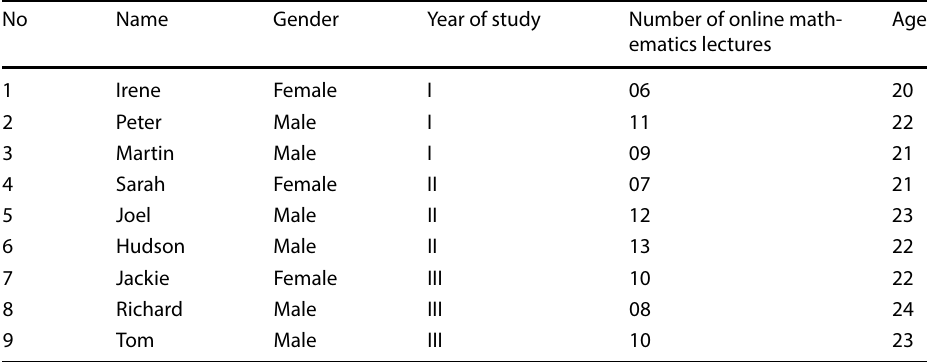
Table 2 Characteristics of the interview